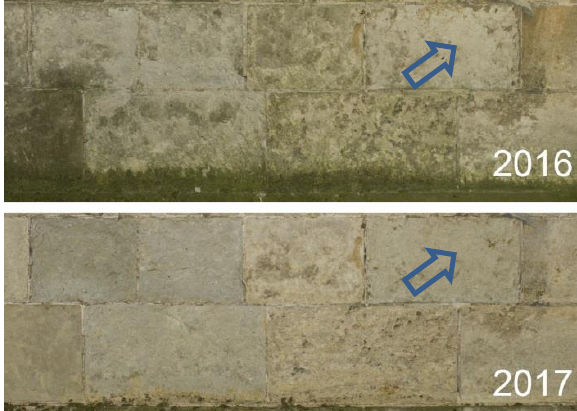
Figure 6. Trial area 1 at Sint Baafs Cathedral. Detail of VIS documentation 2016 and 2017. Blue arrow: reference area for color adjustment